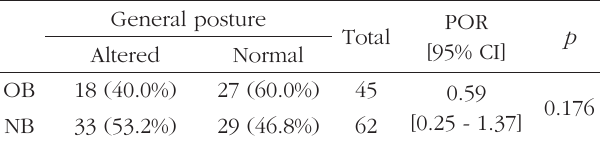
Table 1. Altered general posture in the groups: mouth breathers (OB) and nasal breathers (NB).